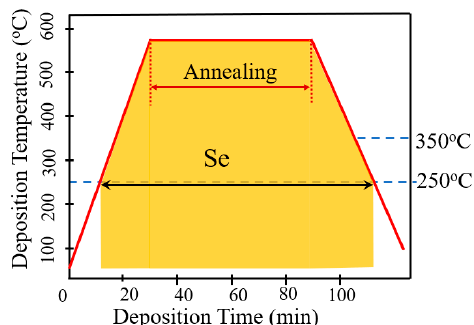
Figure 4. AIGS substrate temperature and Se flux profile during the annealing process.